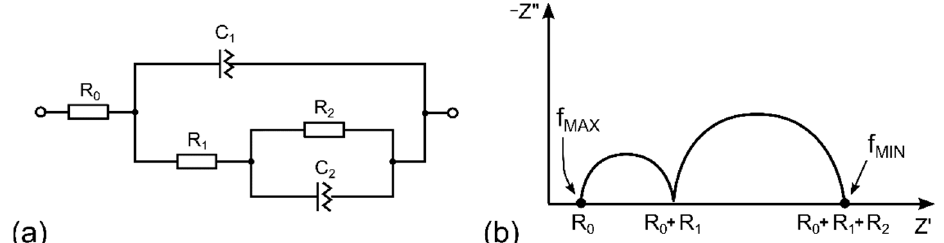
Figure 4. ( a ) Equivalent electric circuit of the NO 2 sensor, ( b ) typical impedance complex plane (Nyquist) plot for a system with two well-separated time constants.